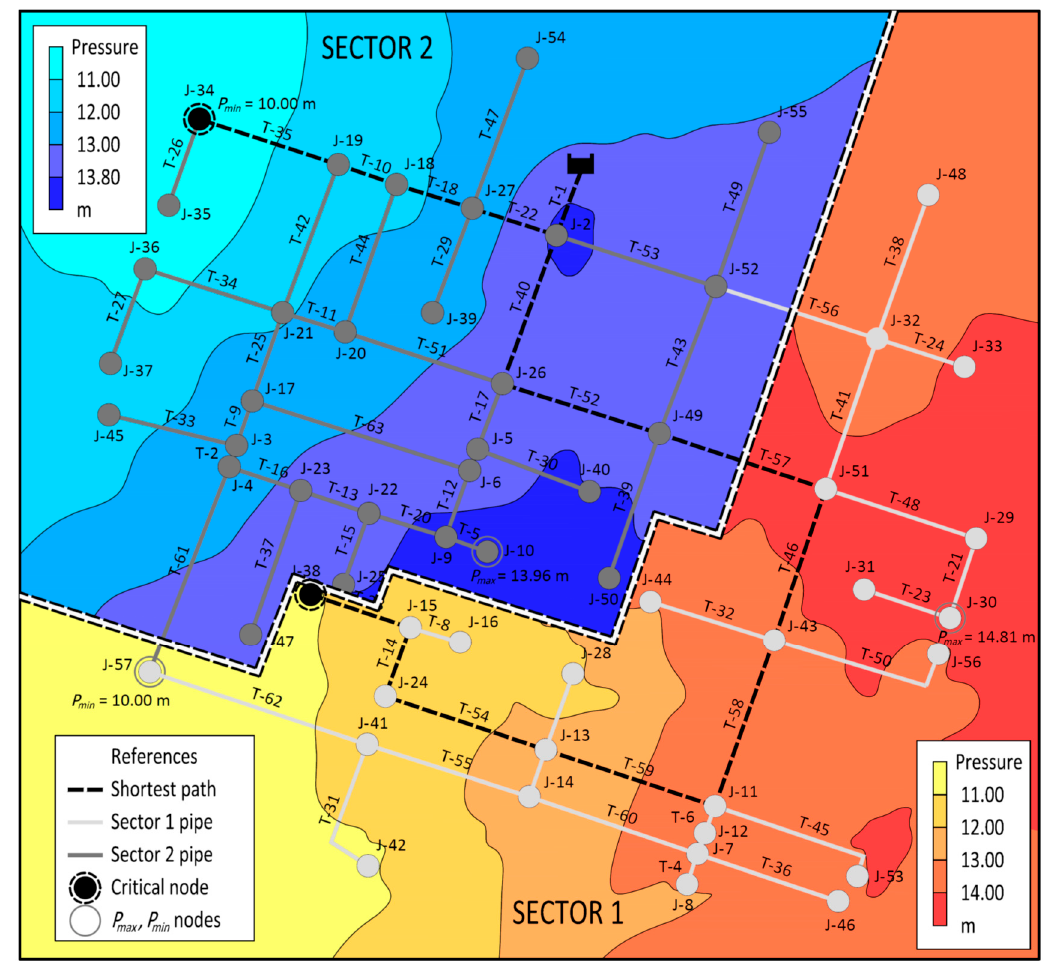
Figure 11. Development of sectors 1 and 2.